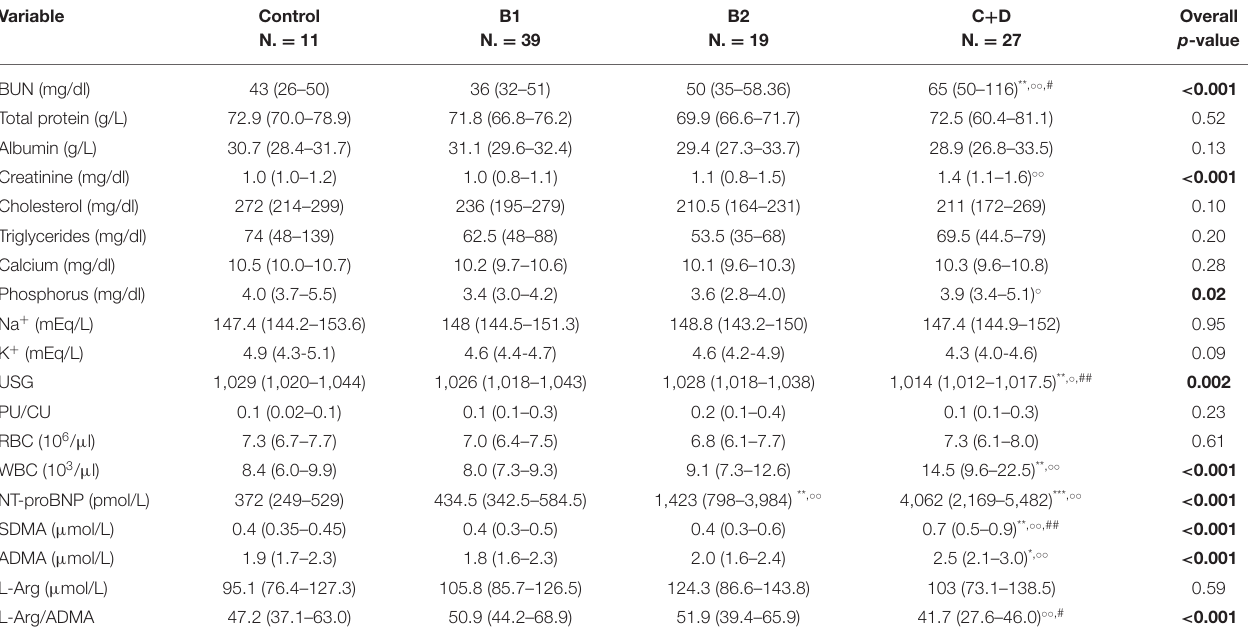
TABLE 2 | Clinical pathology parameters of 11 clinically healthy dogs (Control) and 85 dogs with myxomatous mitral valve disease grouped in different disease stages according to ACVIM guidelines.